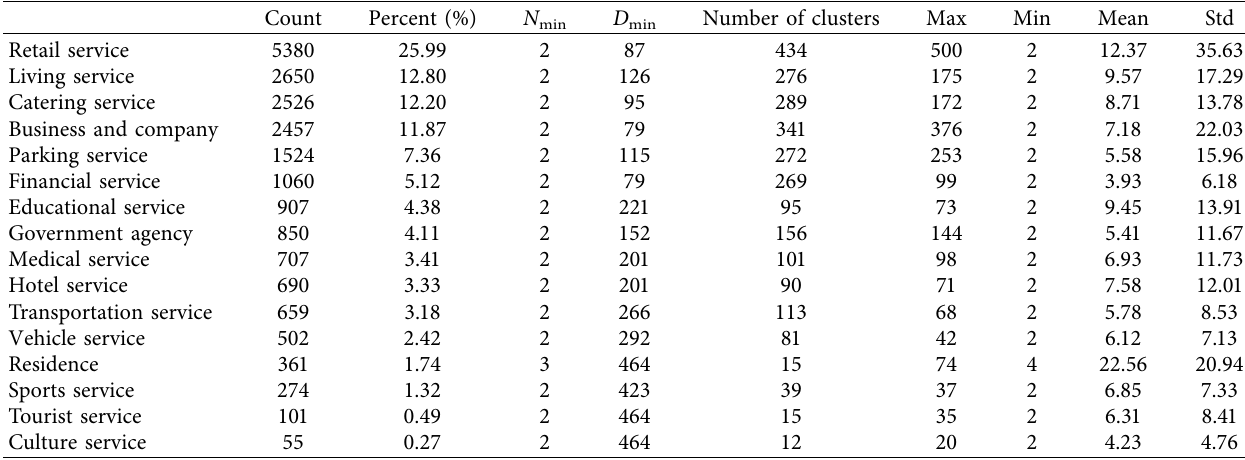
Table 4: Clustering results of diferent types of